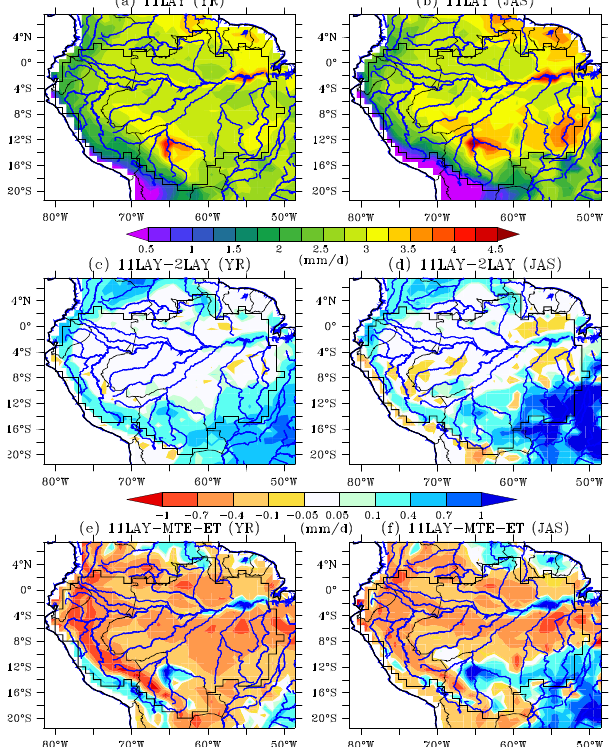
Figure 5. Mean ET (mmd − 1 ) simulated by the 11LAY, averaged over (a) the complete year and (b) JAS, averaged over the period 1980–2008. Differences in simulated ET between the 11LAY and (c, d) the 2LAY and (e, f) the MTE-ET